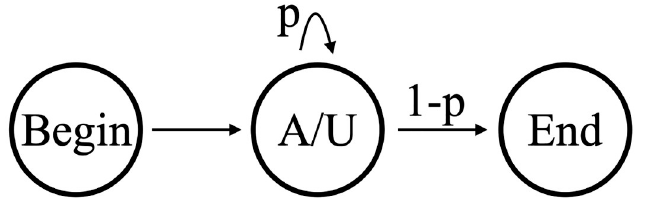
Fig 6. Model B1. The 1-state model (B1) of nontemplated nucleotide addition on Trypanosoma brucei mitochondrial mRNAs.